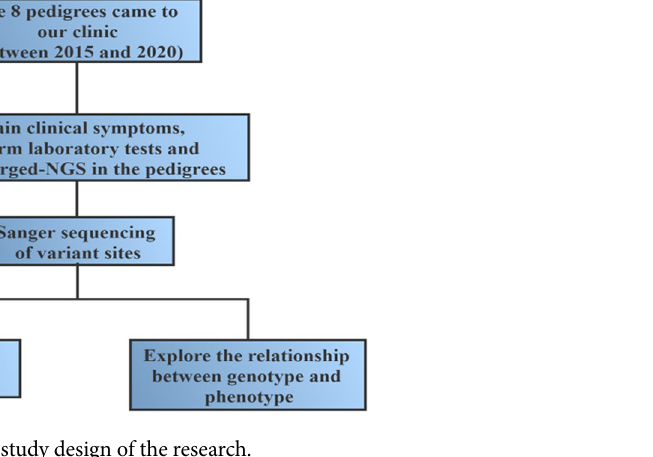
Figure 1. Flowchart of study design of the